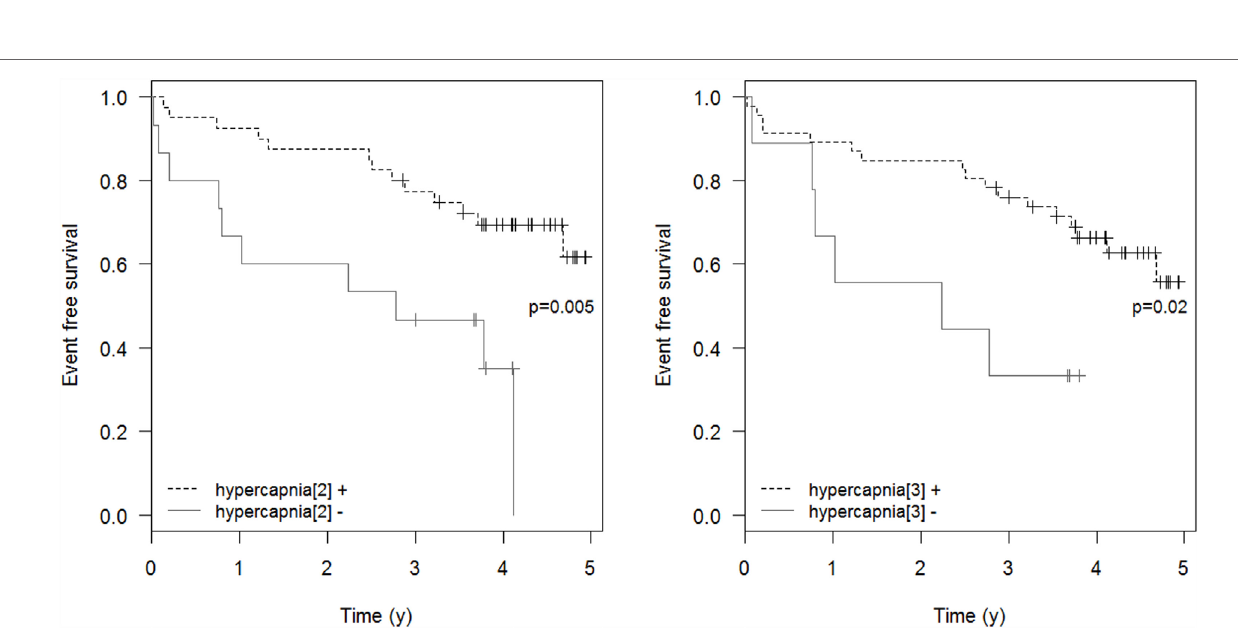
FigUre 3 | event-free survival . Event-free survival: time to the composite endpoint ICU admission or death. “hypercapnia[2]”: TcCO 2 > 49 mmHg during ≥ 10% of the total recording time; “hypercapnia[3]”: peak TcCO 2 > 55 mmHg.